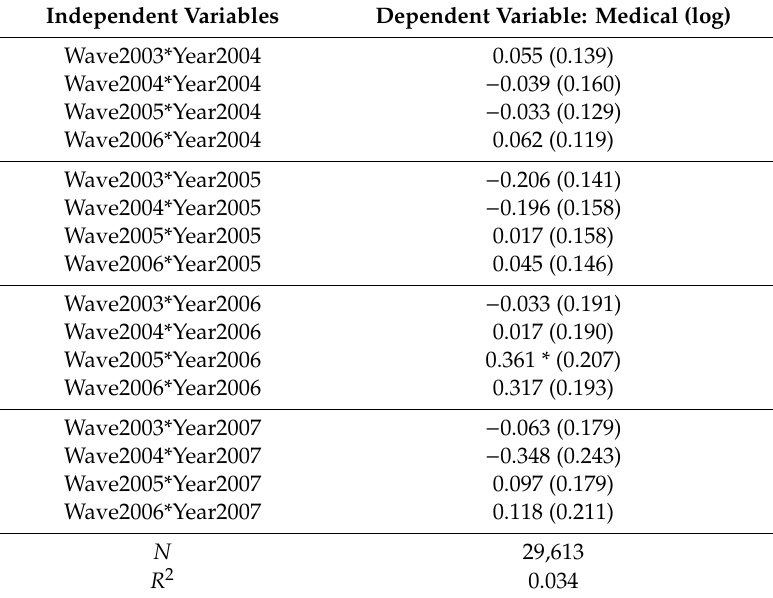
Table 3. Pre-Trend Table 3. Pre ‐ Trend Test.